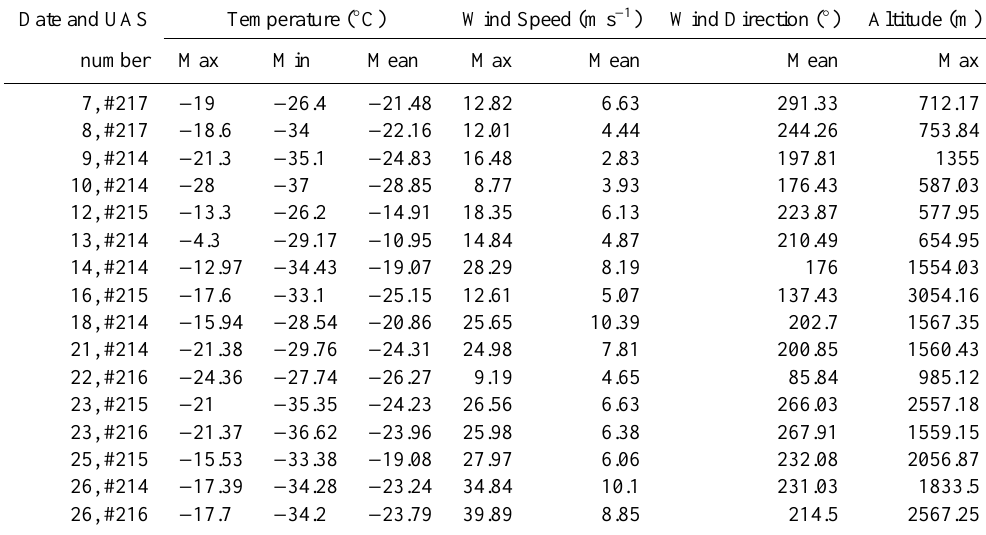
Table 3. Maximum, minimum, and average values for various meteorological variables during each of the sixteen UAS flights. The first column lists the day of September 2009 for the start of each flight and the UAS